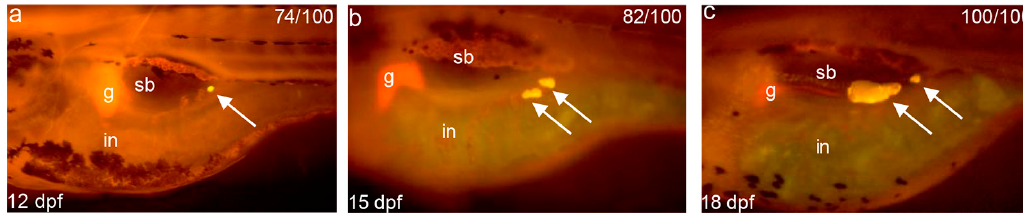
Figure 6. Nile Red staining reveals adipogenesis in zebrafish larval phase. Live zebrafish was stained with Nile Red at: 12 dpf ( a ); 15 dpf ( b ) and 18 dpf ( c ). White arrows annotate adipocyte neutral lipid droplets. The rate of adipogenesis shows on the top right corner. Swim bladder (sb), gall bladder (g), and intestine (in) are indicated. Bars = 400 μ m in ( a – c ).